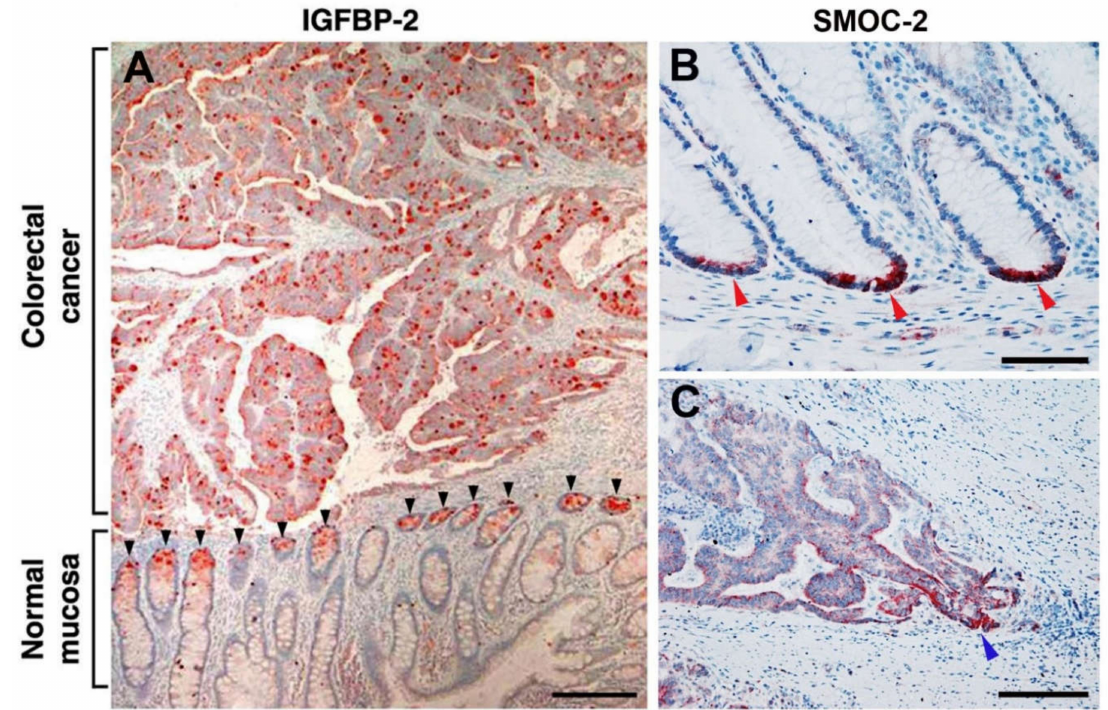
Figure 4. Genes induced by L1 in CRC cells include intestinal stem cell signature genes. ( A ) Insulin like growth factor receptor 2 (IGFBP-2) staining of CRC tissue revealed strong staining of the tumor tissue throughout the tissue, while in the adjacent normal mucosa, IGFBP-2 staining was exclusively confined to the bottom of colonic crypts (black arrowheads). ( B ) The intestinal stem cell signature gene secreted modular calcium-binding matricellular protein-2 (SMOC-2) was detected at the bottom of colonic crypts in normal colonic mucosa (red arrowheads). ( C ) In CRC tissue, SMOC-2 was localized in more di ff erentiated areas of the tumor with stronger staining of invasive areas of the tumor (blue arrowhead) [44,46]. Scale bar: ( A ) 250 µ m, ( B ) 50 µ m, ( C ) 100 µ